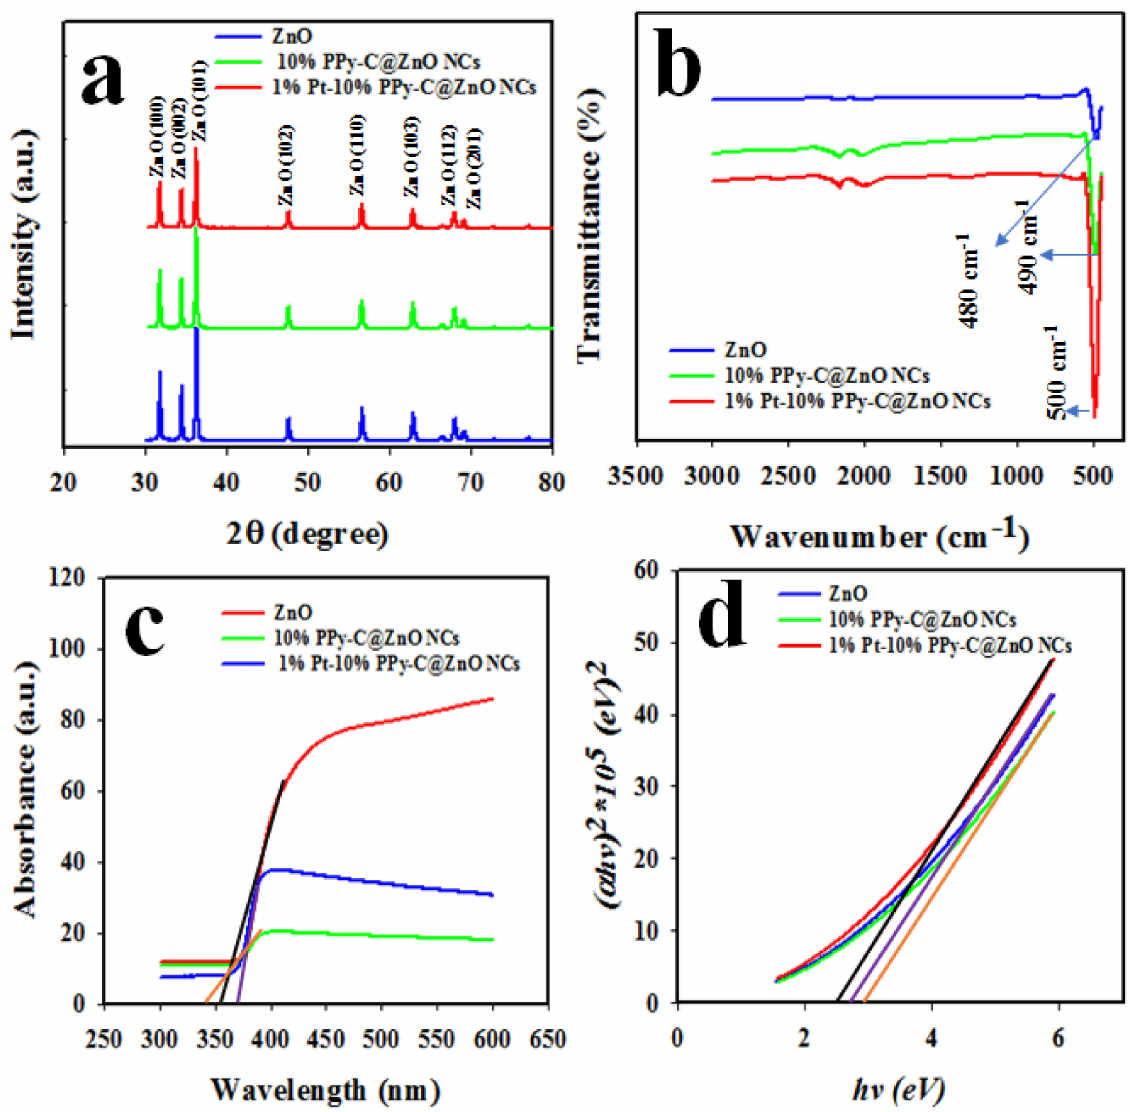
Figure 6. The structural and optical characterization of Pt-NP-embedded PPy-CB@ZnO NCs; ( a ) powder XRD pattern, ( b ) FTIR, ( c ) the UV-visible absorption by prepared NCs, and ( d ) Tauc’s plot using the UV-visible optical